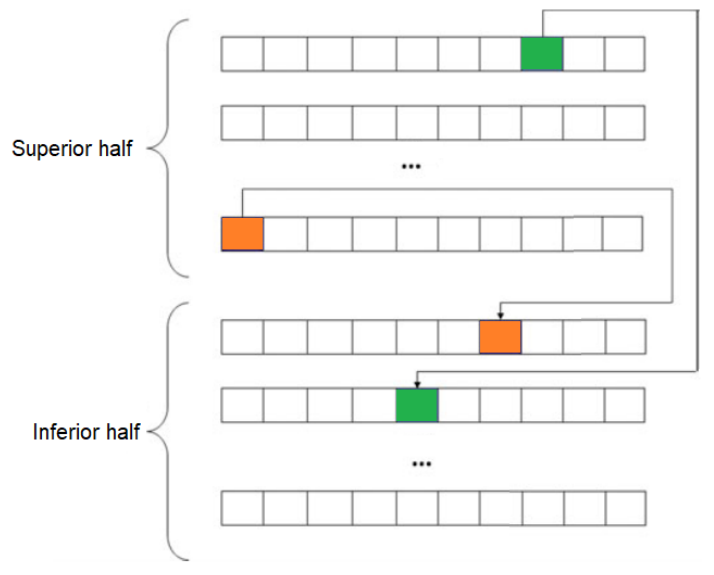
Figure 11. Illustration of a gene